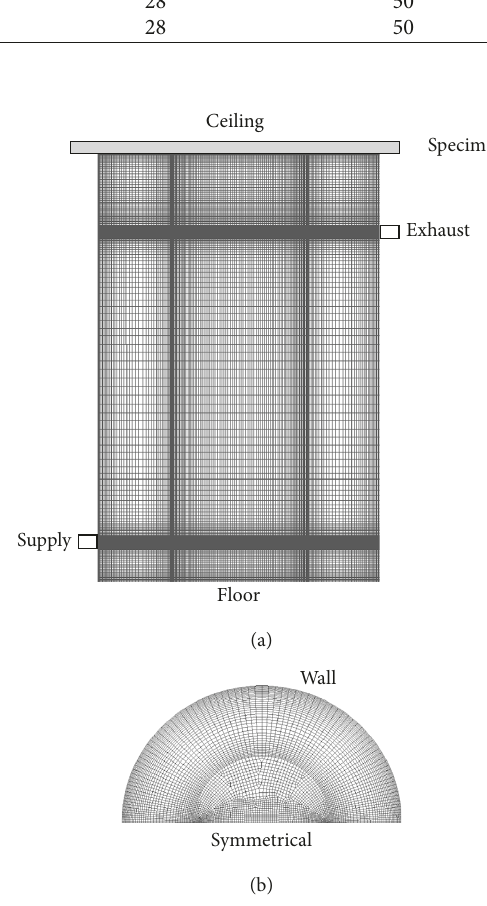
Figure 3: Schematic of the analytical mesh: (a) vertical cross section (symmetrical) and (b) horizontal cross